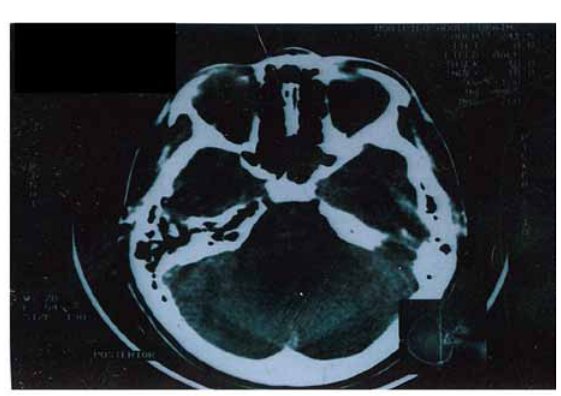
Figure 3. CT scan - one month after surgery.